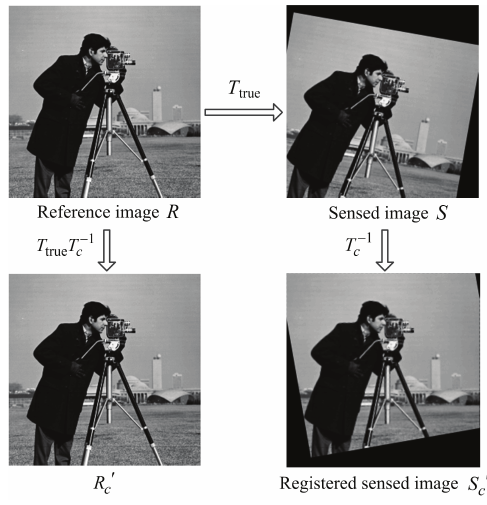
Figure 7. Relationship among R , S , R c (cid:48) and S c (cid:48)